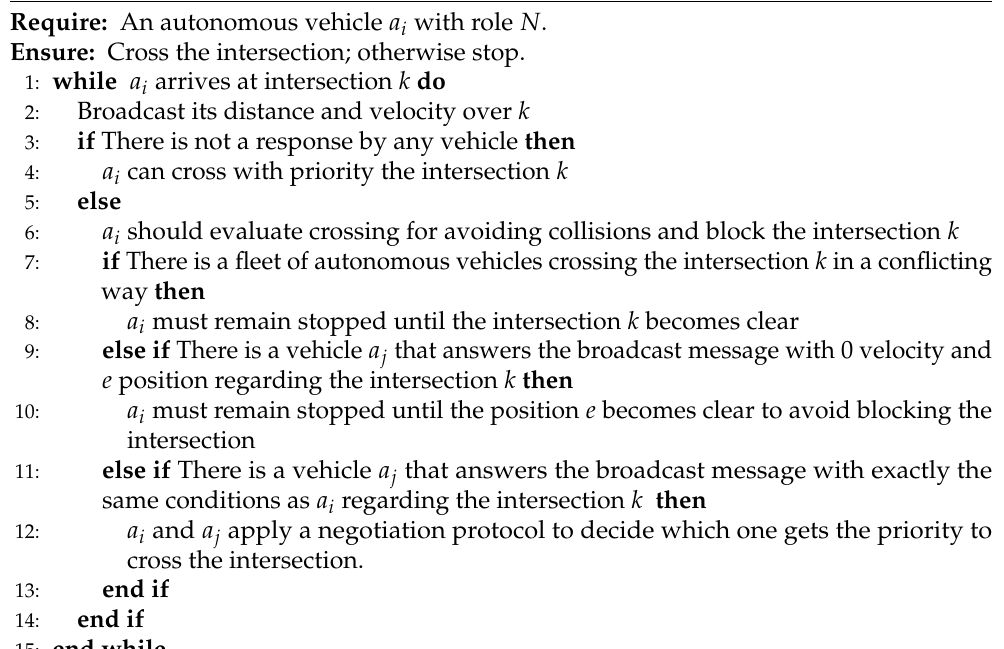
Algorithm 1 Coordination intersection